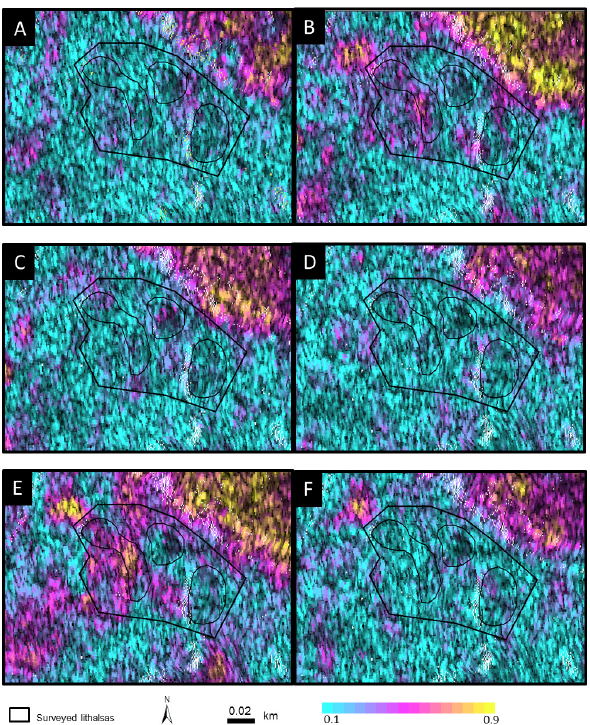
Figure 8. The coherence values of the six interferograms in the area of the three lithalsas of interest, near Umiujaq, northern Que- bec, Canada (A: 14 August–7 May 2009; B: 14–25 August 2009; C: 14 August–30 October 2009; D: 12 August–5 May 2010; E: 12– 23 August 2010; and F: 12 August–28 October